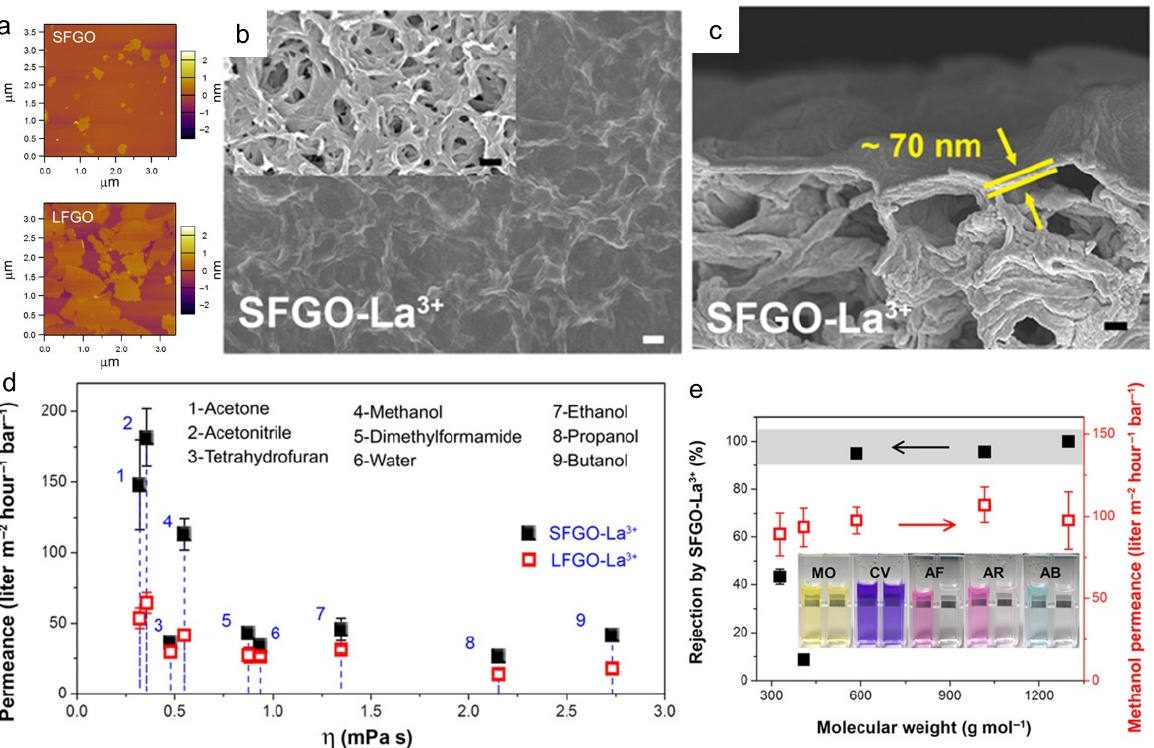
Figure 4. Graphene membrane comprised of small flake GO (SFGO). ( a ) Atomic force microscopy (AFM) topographies showing the height images of the small-flake GO and large-flake GO (LFGO) nanosheets. ( b , c ) Field-emission scanning electron microscopy (FESEM) images of the ( b ) surface and ( c ) cross-sectional morphologies of the SFGO-La 3+ membrane (white scale bars, 1 µ m; black scale bars, 200 nm). Inset of ( b ): FESEM image of the underlying nylon substrates (black scale bars, 1 µ m). ( d ) Permeance of pure water and various pure organic solvents through the SFGO-La 3+ and LFGO-La 3+ membranes as a function of their viscosities. ( e ) Separation performances of the SFGO-La 3+ membrane using various 10 ppm solutions containing organic dyes of different charges and molecular weights of methanol [76]. Copyright 2020 The American Association for the Advancement of